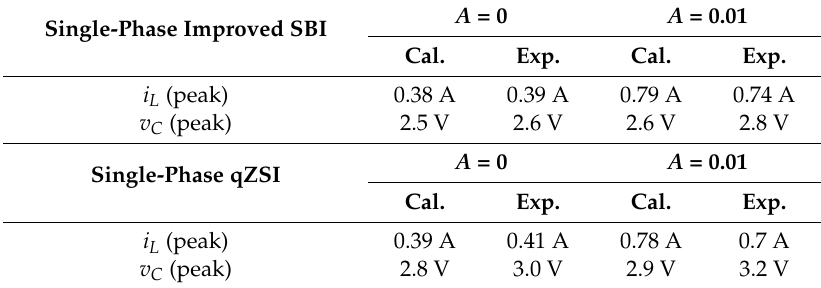
Table 2. Theoretical and experimental results of amplitudes of 2 ω voltage and current